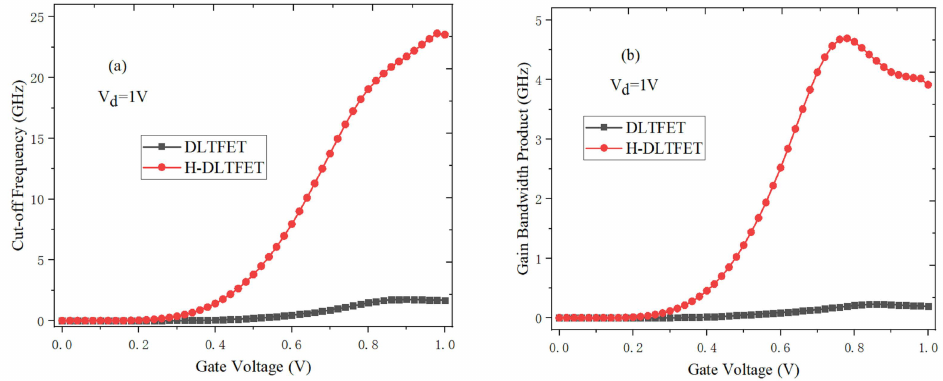
Figure 11. ( a ) Cut-o ff frequency, ( b ) Gain bandwidth product of DLTFET and